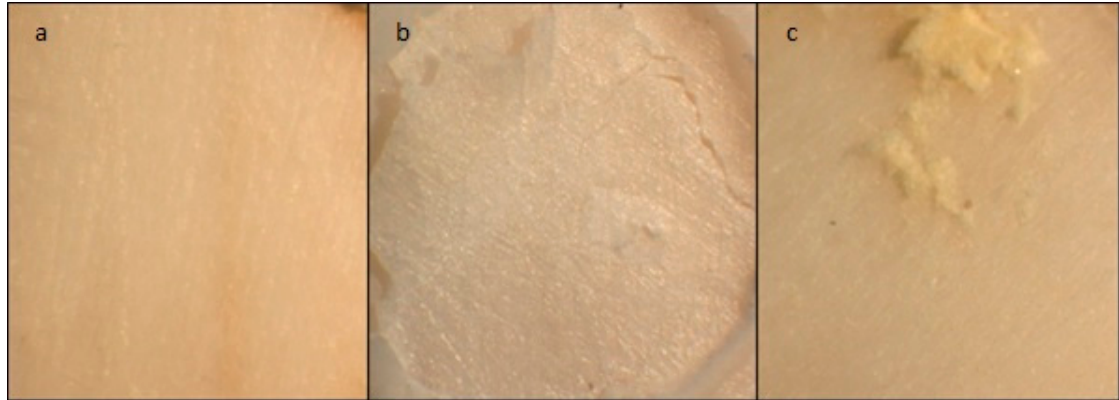
Figure 6. Stereomicroscope images of dentine showing the three failure modes at a magnification of 12×. ( a ) adhesive failure; ( b ) cohesive failure; ( c ) mixed failure.